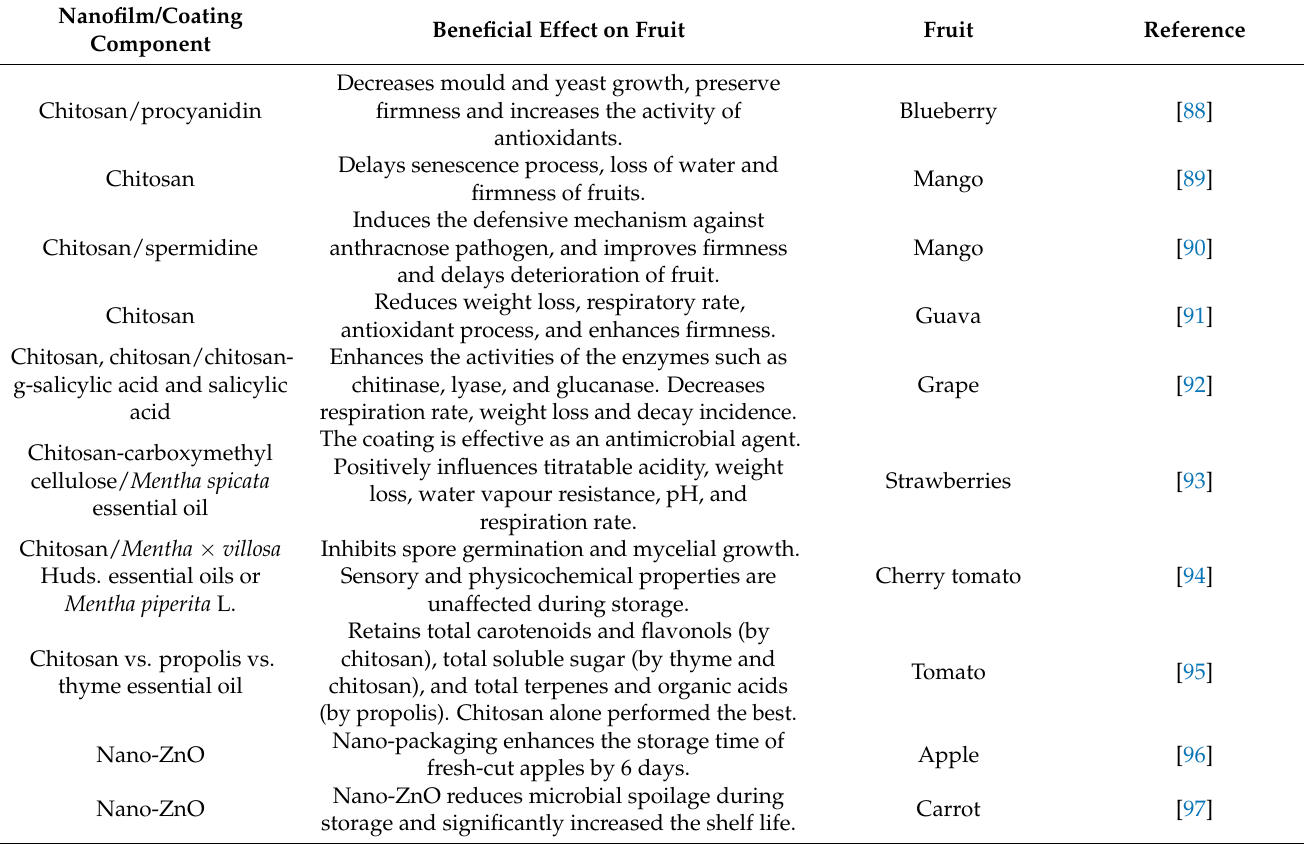
Table 3. Effect of nano components on different horticultural